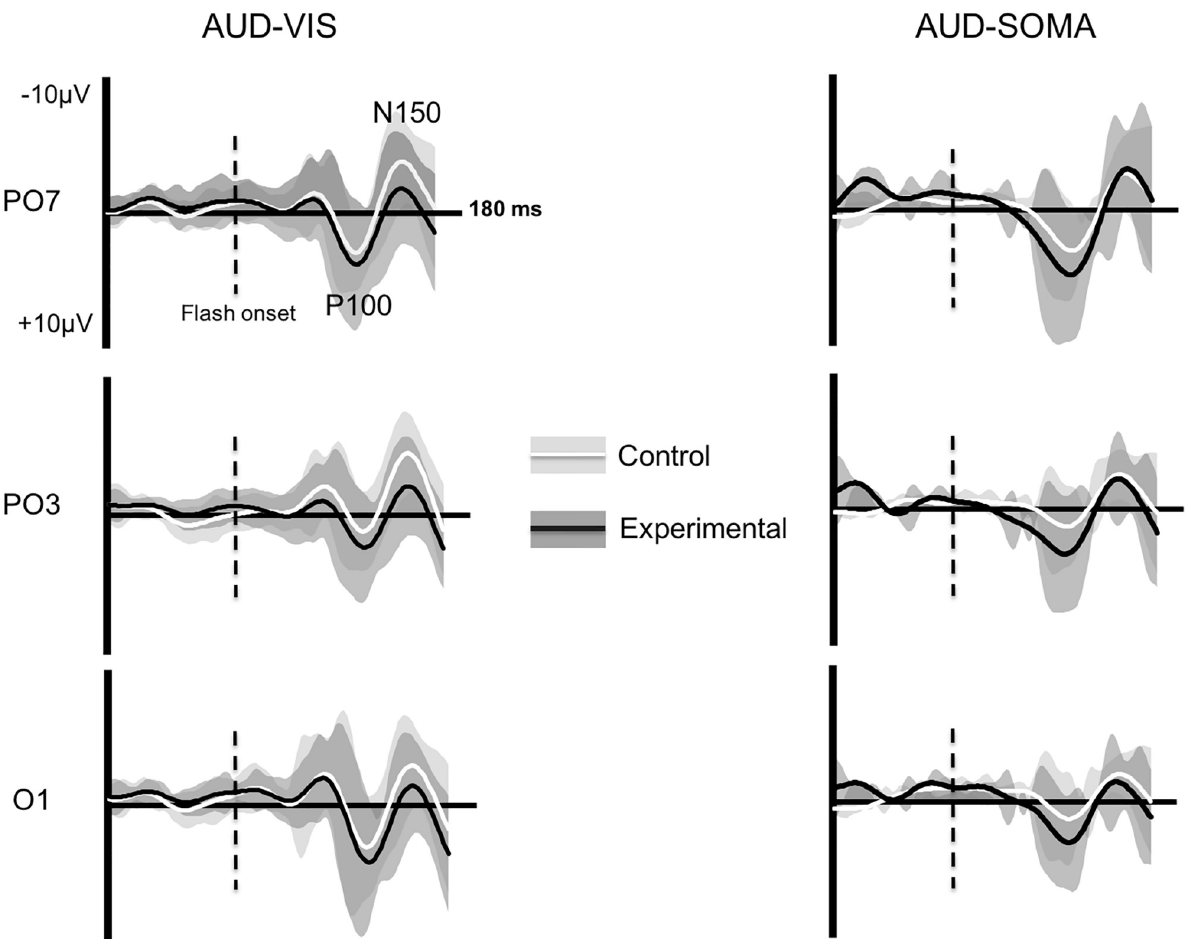
Fig 4. Grand average VEPs for each electrode in the AUD-VIS and AUD-SOMA conditions (error patches represent the between-participant standard deviation).